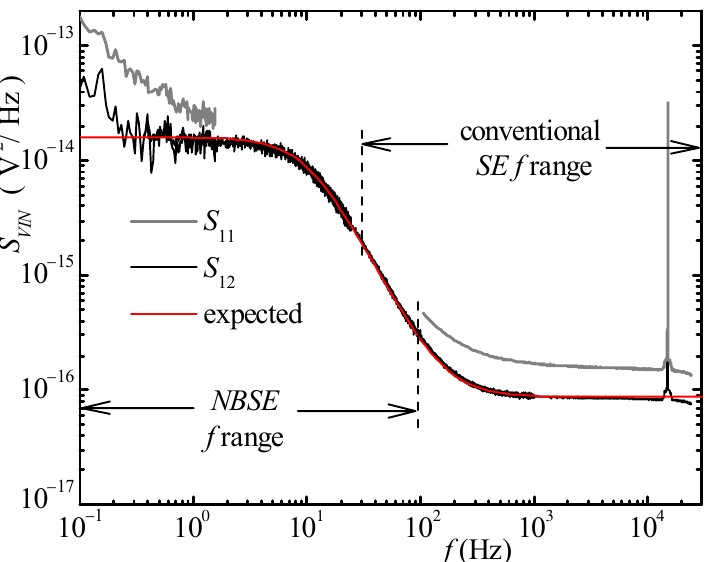
Figure 7. Result of noise measurements with the switch SW open in Figure 5. The red curve represents the expected result (nominal voltage noise across Z DUT ). The gray curves represent the portion of the equivalent noise input as would be measured with a single amplifier ( CH 1). The black curve is the noise obtained from the cross-correlation between the two amplifiers. The frequency regions where spectra have been obtained from conventional Spectral Estimation (SE) and from NBSE are shown in the figure to evidence the frequency region in which the two results superimpose. The deviation with respect to the nominal value that can be observed above 10 kHz is due to the bandwidth limitation of the amplifiers in Figure 5. The deviation at frequency below 200 mHz is due to the fact that the measurement time was not sufficient to cause the complete rejection of the uncorrelated noise at these very low